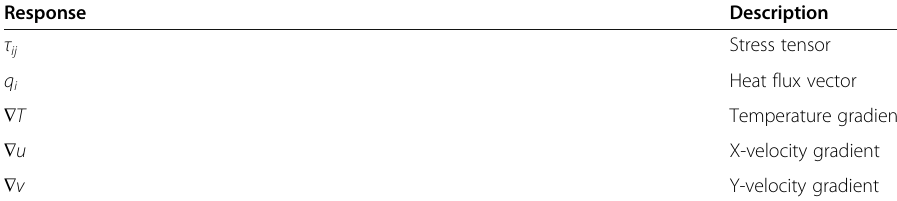
Table 2 Responses used as output in the regression for DNCR Response